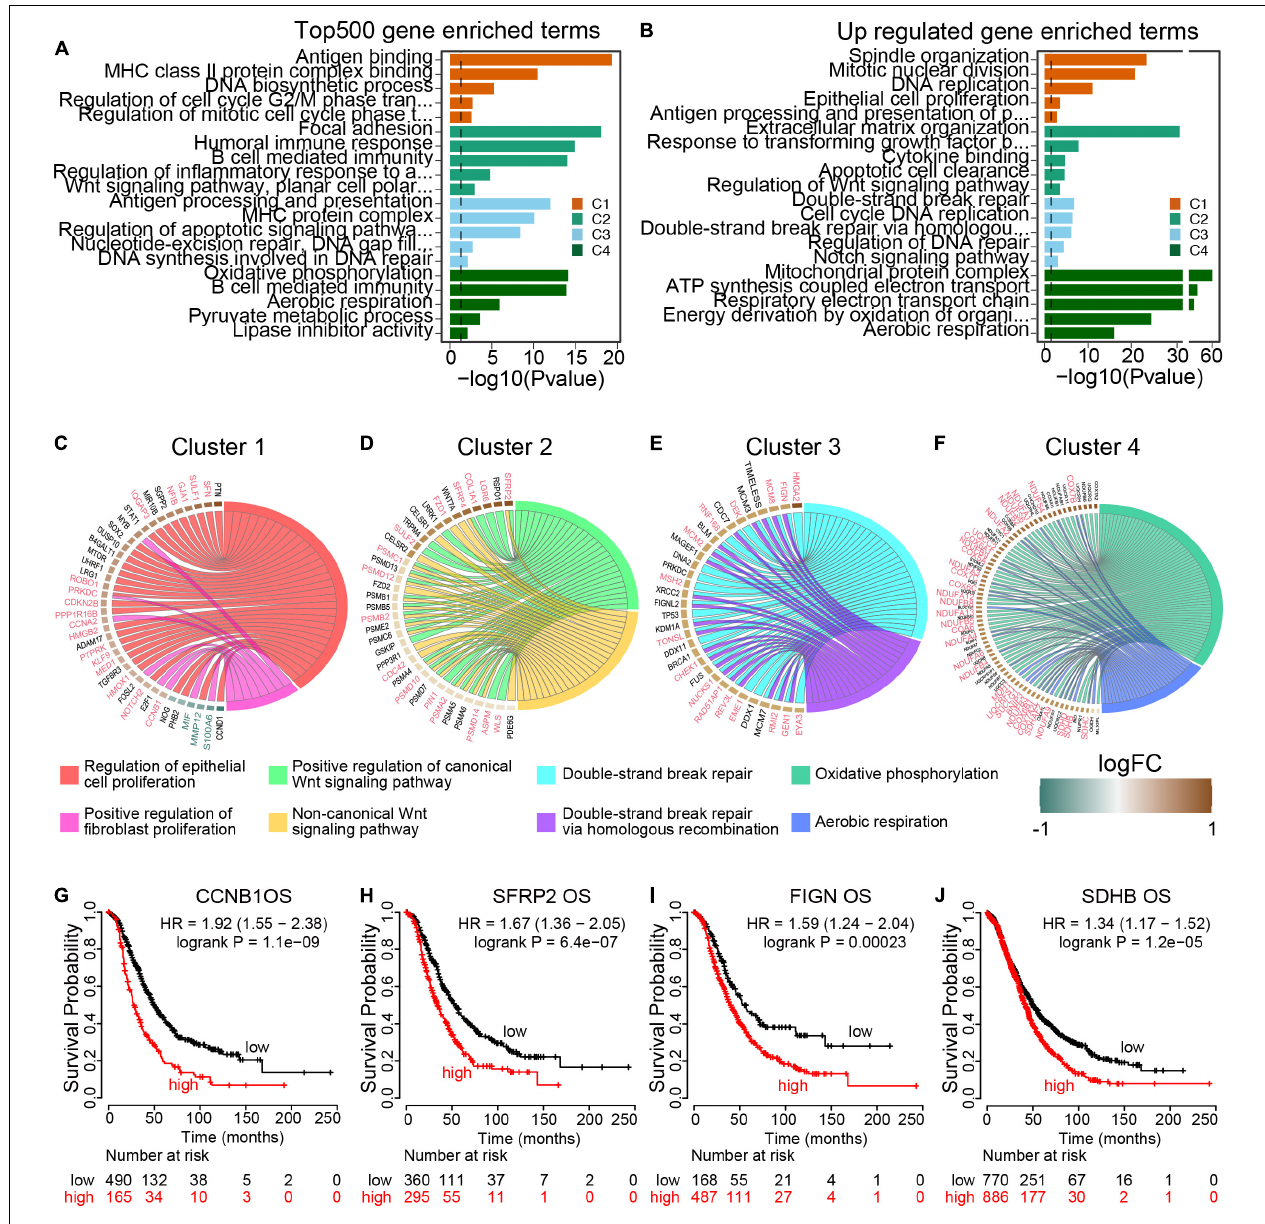
FIGURE 5 | Transcriptome traits in distinct m 6 A modification patterns. (A) GO terms enrichment using the top 500 expressed genes in each m 6 A modification patterns. (B) GO terms enrichment using the upregulated genes from each cluster compared to the rest cases. (C–F) Circos plot exhibits the essential cancer associated GO term clusters of the four m 6 A modification patterns with the differential expressed genes (fold change > 1.5 and p value < 0.05). Genes with good prognosis in high grade serous ovarian cancer are highlighted by red color, and the green for good prognosis genes. Each square represents the fold change of genes between each m 6 A modification patterns and the rest cases. Brown color for upregulated genes and green color for downregulated genes. (G–J) Overall survival curves of representative genes enriched in each m 6 A modification